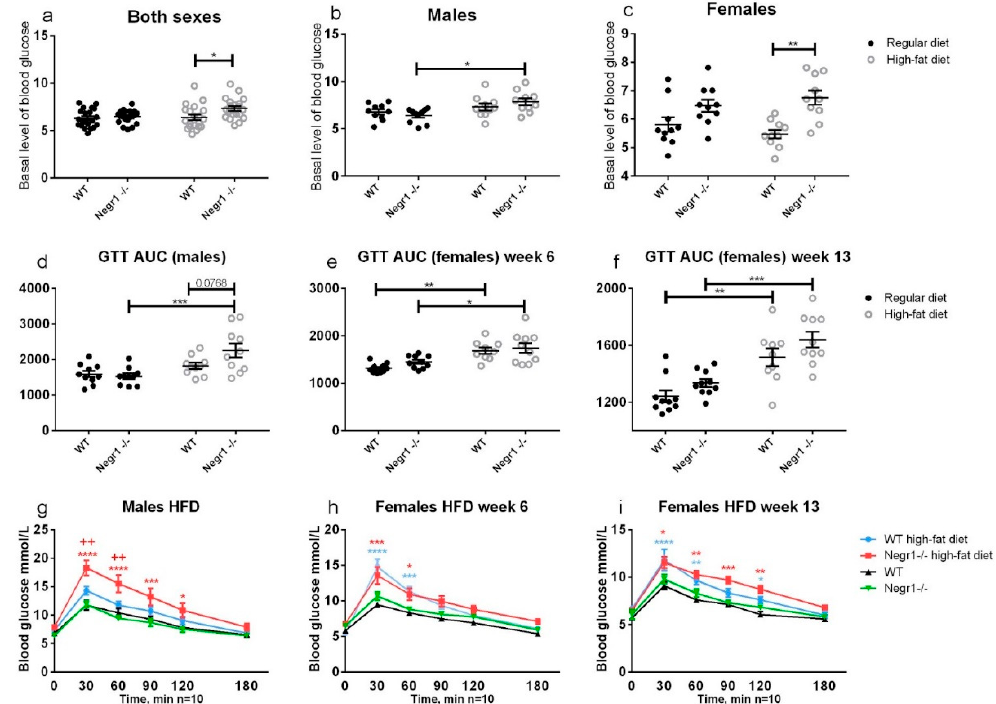
Figure 3. The basal level of glucose and glucose tolerance test. Basal level of glucose after 6 weeks of HF/standard diet when ( a ) both sexes were pooled together, ( b ) in the male group, and ( c ) in the female group. ( d , g ) Glucose tolerance test was performed for males after 6 weeks on the HF diet, and for females ( e , h ) after 6 and ( f , i ) 13 weeks of HF diet. ( d – f ) The bioavailability of glucose was estimated by calculating the area under the curve of plasma concentration (AUC) over the measured timepoints. ( g – i ) Mean values of blood sugar at different timepoints. Data represent mean ± SEM, * p ≥ 0.05, ** p ≥ 0.01, *** p ≥ 0.001, **** p ≥ 0.0001 (diet effect), ++ p ≥ 0.01 (genotype effect), two-way ANOVA (Bonferroni post hoc test (basal level of glucose), Tukey post hoc test (GTT)).